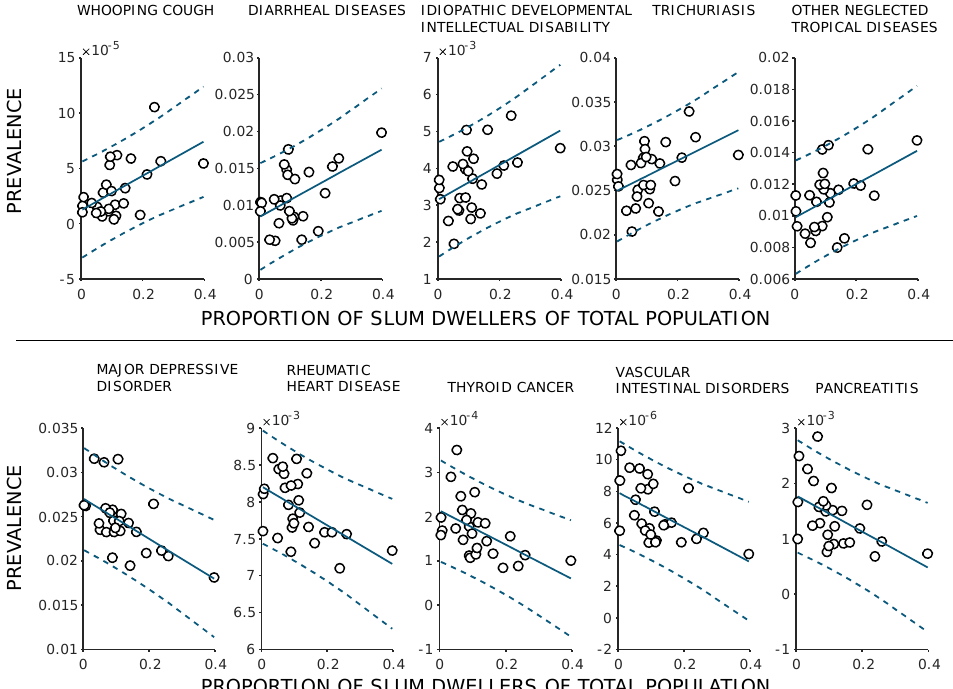
Figure 9. Prevalence of each of the five diseases that show the strongest positive and negative correlation with the proportion of slum population per region. The dots represent the data points of the 27 regions of Brazil, the blue line represents a linear regression through the dots, and the dotted line represents the 95% interval of the